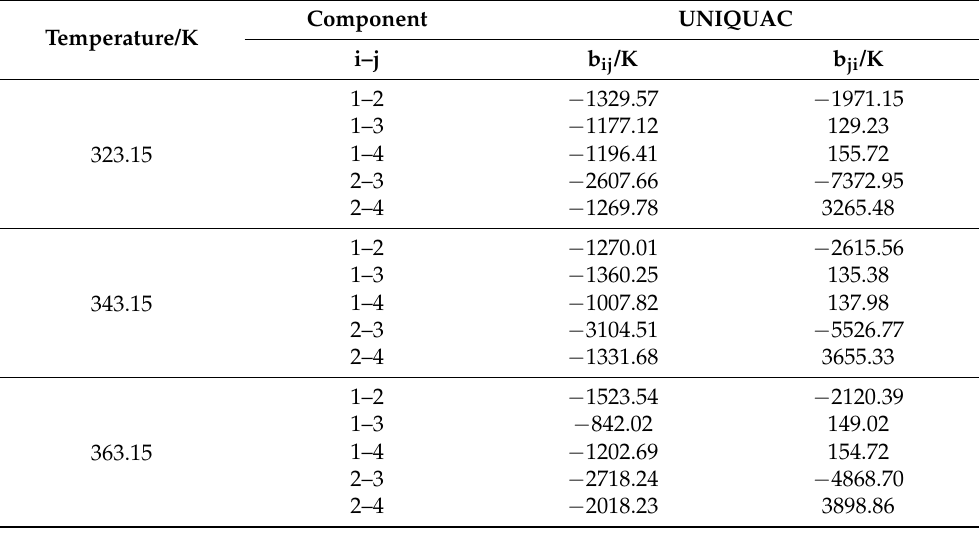
Table 5. UNIQUAC model parameters for LA (1)-OL (2)-OC (3)-water (4)